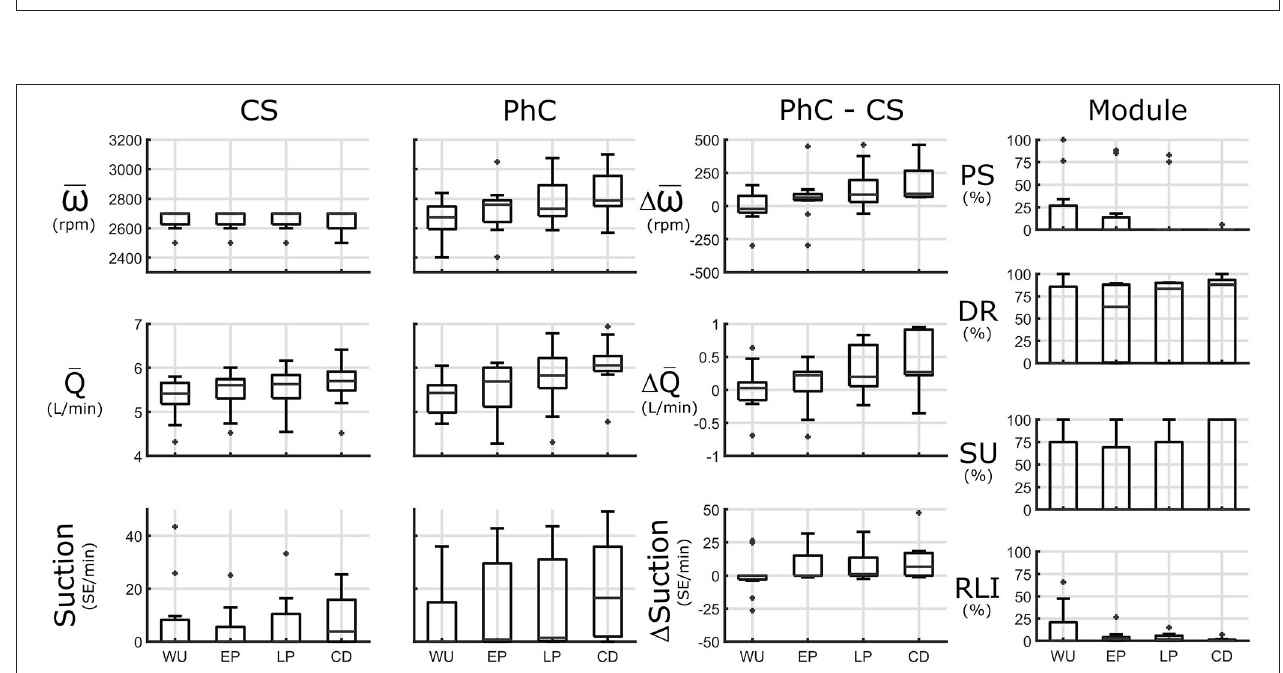
FIGURE 3 | Steady state posture differences between standing(H), sitting (M), supine (L). Left panels: Speed ( ω ), flowrate (Q), and suction [in Suction Events (SE)/minute] in constant speed (CS) and physiologic control (PhC) and their differences. Module panel: control module activation for pulsatility (PS), demand response (DR), suction response (SU), and rate limited increase (RLI) modules. Speed is reduced in all postures in PhC modes compared to CS resulting in reduced flowrates and reduced suction burden during standing. DR module mainly governs set speed in supine and sitting position with increasing contributions from the SU modules while standing.